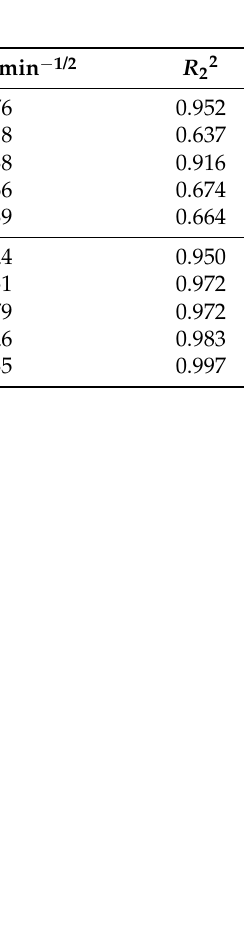
Figure 8. The influence of the number of adsorption-desorption cycles on the removal effect.